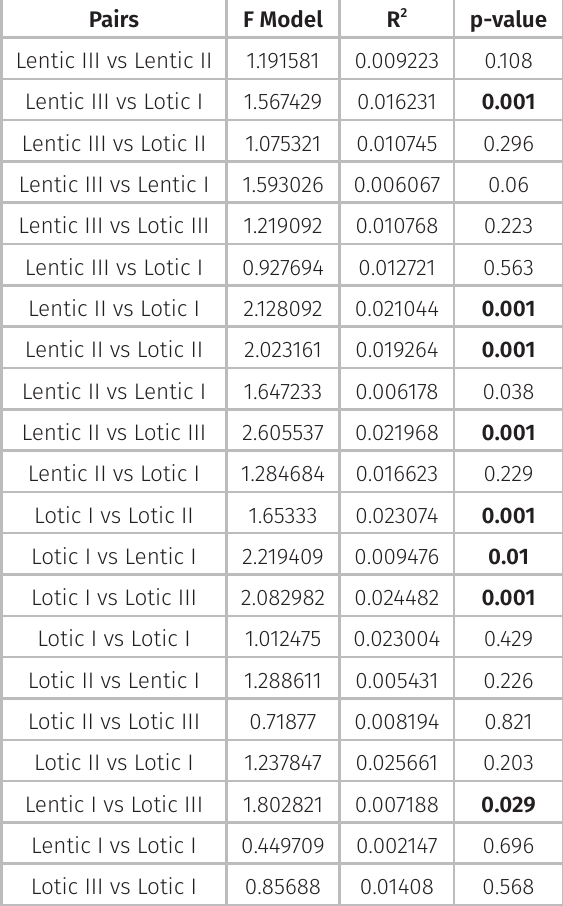
Table III. Permanova results comparing Astyanax lacustris diet from lotic and lentic sites of Chavantes Reservoir, Middle Paranapanema River. p-values <0.05 are shown in